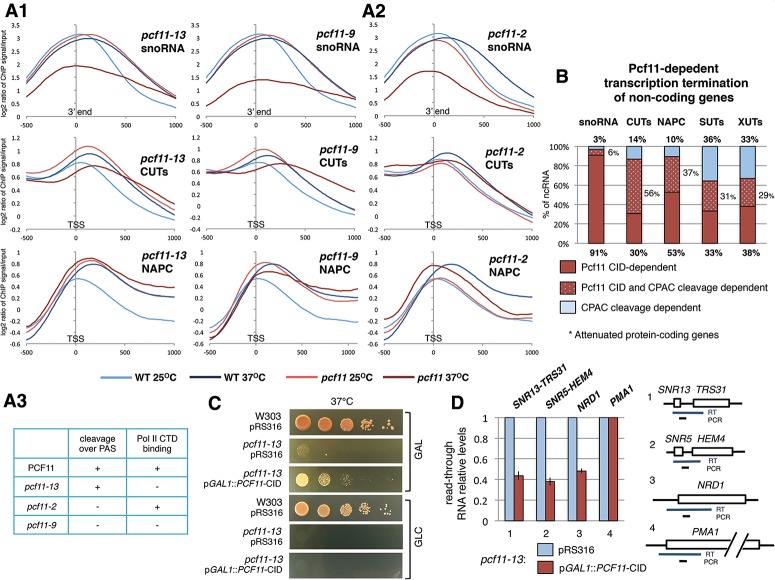
Pcf11 CID regulates NRD-dependent transcription termination. (A1,A2) Metagene analysis of Pol II occupancy in various PCF11 mutants. Pol II signal was aligned to the snoRNA 3′ mature end or the TSS of CUTs and NAPC genes. Pol II was precipitated with the anti-CTD antibody CMA601. Plots present ChIP-seq signals smoothed with a 220-nucleotide (nt) moving average. (A3) Phenotypes of PCF11 mutants (Amrani et al. 1997; Sadowski et al. 2003). (B) Transcription termination pathway distribution for Pcf11-dependent genes. (C) Suppression of temperature-sensitive pcf11-13 growth by the episomal Pcf11 CID at 37°C. Expression of the CID was controlled by the GAL1 promoter. Dilutions (1:10) were plated on YPGAL (inducing condition) or YPD (repressing condition) and grown for 4 d. (D) Accumulation of aberrant readthrough transcripts in pcf11-13 detected following episomal expression of the Pcf11 CID by RT-qPCR analysis. Levels of readthrough transcripts were normalized to PMA1 mRNA. Diagrams show reverse-transcribed regions and positions of qPCR amplicons. pRS316 was the control empty vector.